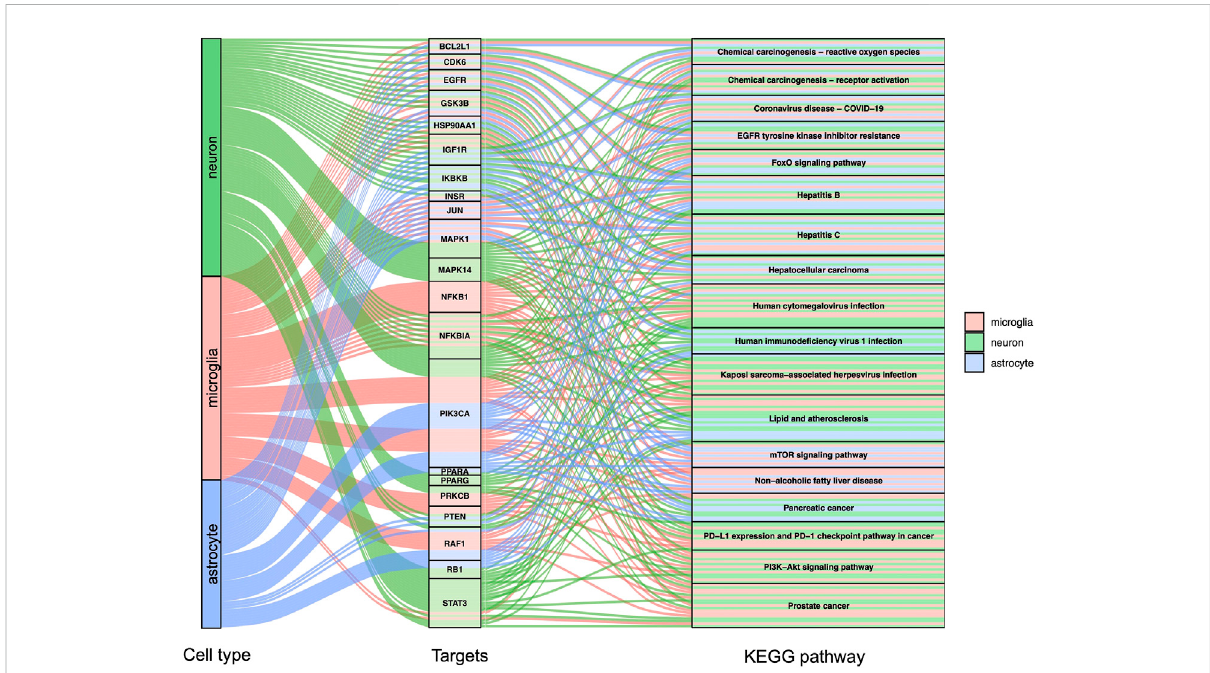
FIGURE 4 KEGG enrichment analysis for potential GBE targets for PD. Sankey diagram showed top enriched KEGG pathways and according to targets in 3 cell types. p < 0.0015 in all shown